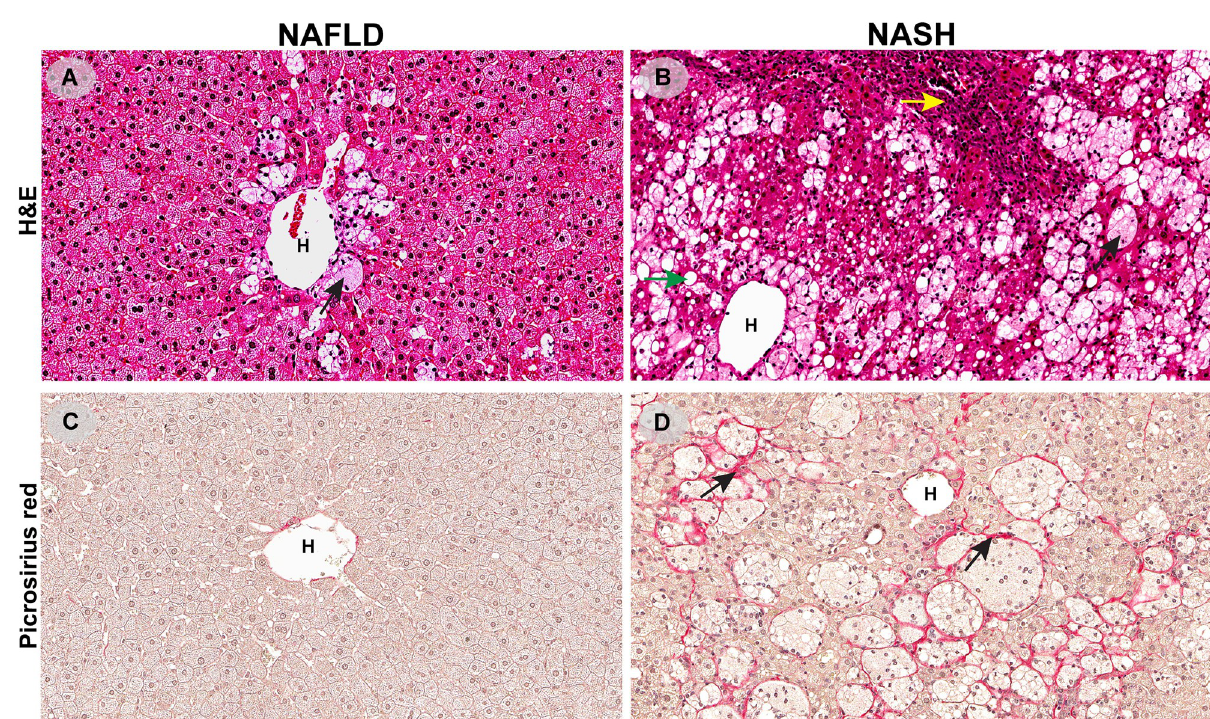
Fig 1. Characteristics of non-alcoholic fatty liver disease (NAFLD, A and C) and non-alcoholic steatohepatitis (NASH, B and D). Liver tissues were stained with hematoxylin and eosin (H&E, A and B) and picrosirius red (C and D). A and C illustrate NAFLD. A): In this case of mild NAFLD steatosis, scattered micro-vesicles are seen in the hepatic lobules and with a predominantly perivenular distribution associated with ballooning (black arrow). C): Fibrosis is almost absent in NAFLD between lobules. B and D represent NASH. B): Macro-vesicular steatosis is scattered in the hepatic lobule (green arrow) and swollen (ballooned) hepatocytes are apparent with rarefied cytoplasm (black arrow). Periportal inflammation can be seen as a mixed inflammatory infiltrate consisted of mainly mononuclear cells as shown (yellow arrow). D): Pericellular and perisinusoidal lobular fibrosis (black arrows). H, hepatic